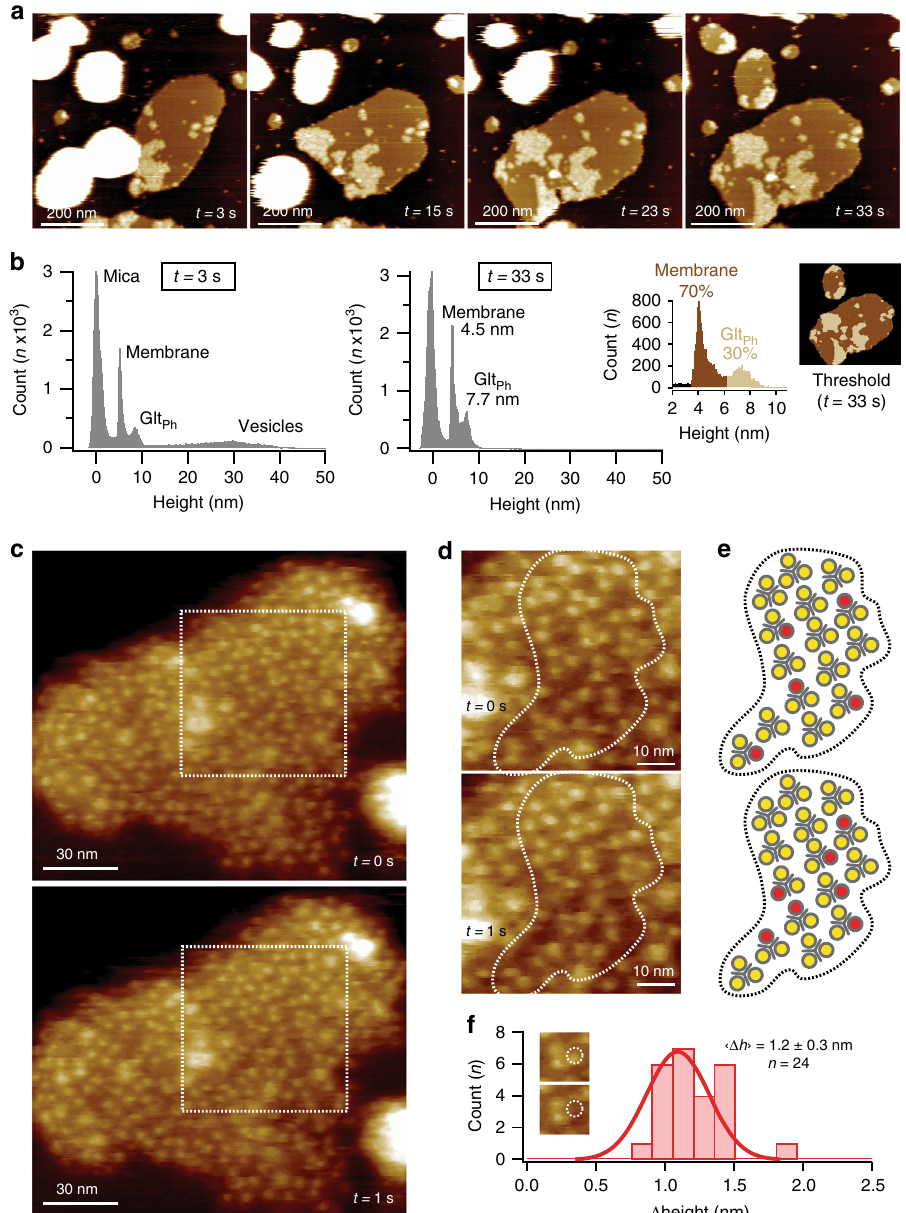
Fig. 1 HS-AFM imaging of Glt Ph morphology and activity in membranes. a HS-AFM movie frames of Glt Ph proteo-liposomes spreading on mica (Supplementary Movies 1 and 2; representative for >50 experimental replicates). b Height distribution analysis: initially ( t = 3 s) intact vesicles (height: ~30 nm) adsorb to the surface (de fi ned height: ~0 nm) that eventually ( t = 33 s) spread into membrane sheets (height: ~4.5 nm) with Glt Ph domains (height: ~7.7 nm). Right: membrane packing analysis with thresholds at 3.5 nm < membrane <6.1 nm and 6.1 nm < Glt Ph < 10 nm. Membranes are ~30% Glt Ph -packed. c Consecutive high-resolution images. d Zoomed areas of the dashed outlines in c showing Glt Ph trimers and protomer activity (representative for >50 experimental replicates). e Schematic representation of the dashed outlines in d , where yellow and red circles represent outward- and inward-facing protomers, respectively. f Height change ( Δ height) distribution of protomer “ elevator ” motions in c . Mean± s.d. are indicated ( n = 24). Inset: example protomer (dashed